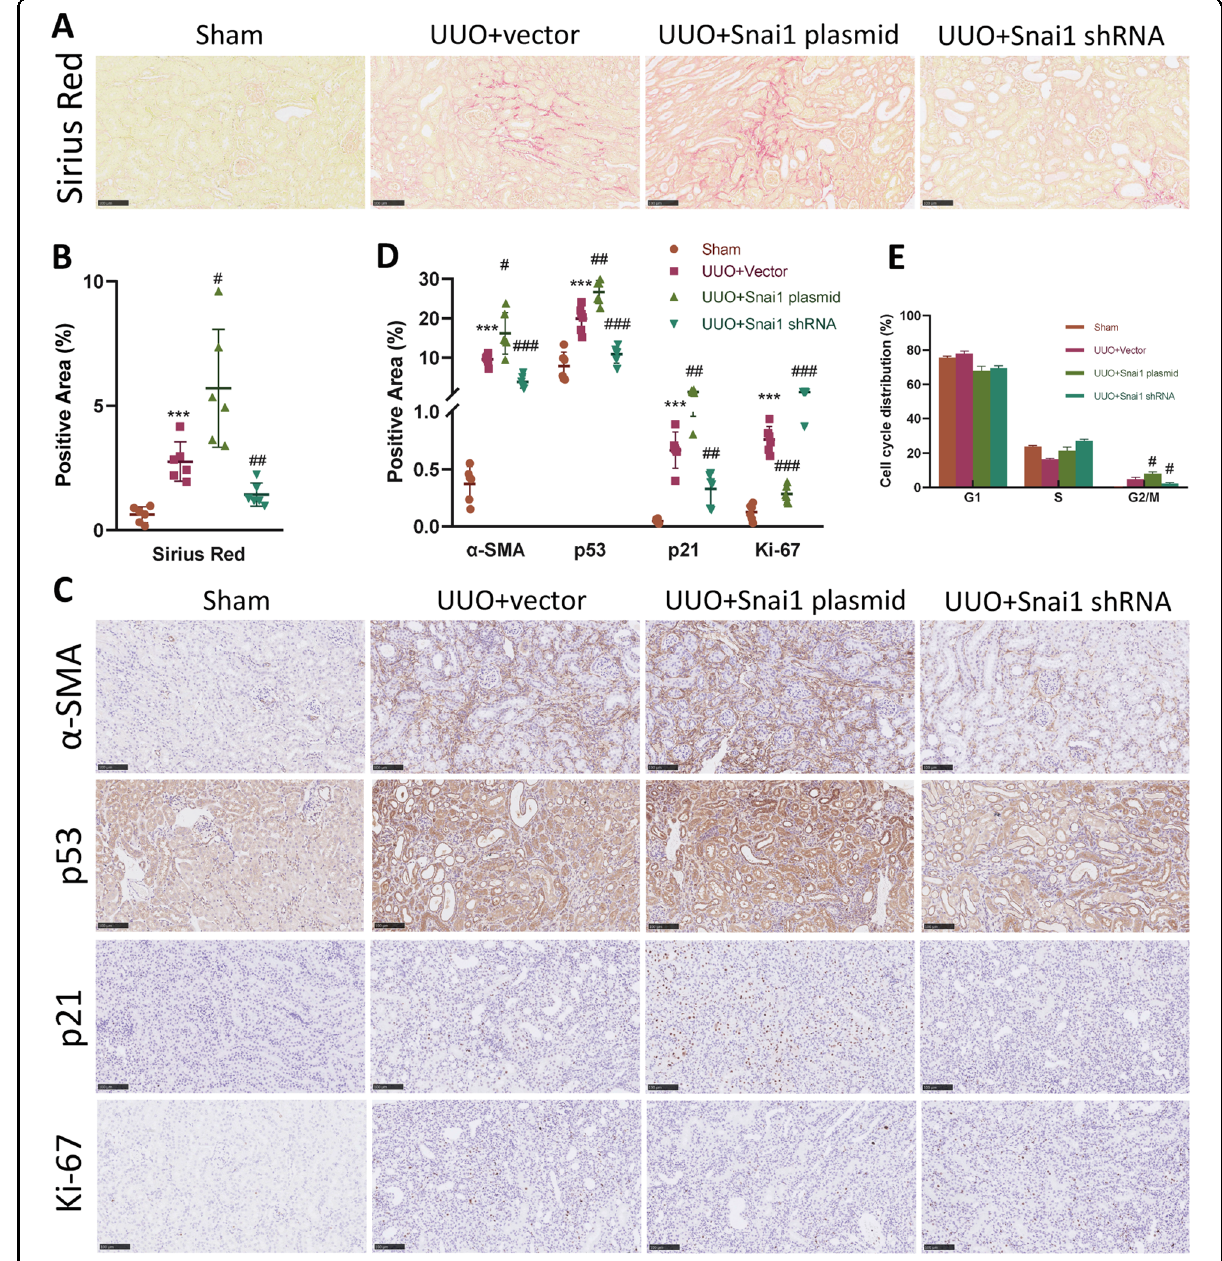
Fig. 4 Regulation of Snai1 expression changes EMT and G2/M arrest. UUO mice were injected with plasmid encoding either Snai1 mRNA or shRNA to regulate the expression of Snai1 1 day after UUO establishment. A Sirius red staining of kidney from sham, UUO + vector, UUO + Snai1 plasmid, and UUO + Snai1 shRNA group, and B their quanti fi cations. Scale bar = 100 μ m. C Immunohistochemistry staining of α -SMA, p53, p21, and Ki-67 in different groups, and D their quanti fi cations. Scale bar = 100 μ m for α -SMA and scale bar = 50 μ m for p53, p21, and Ki-67. E Cell cycle distribution of TECs isolated from obstructed kidneys in different groups. *** P < 0.001 compared with the sham group. # P < 0.05; ## P < 0.01; ### P < 0.001 compared with the UUO + vector